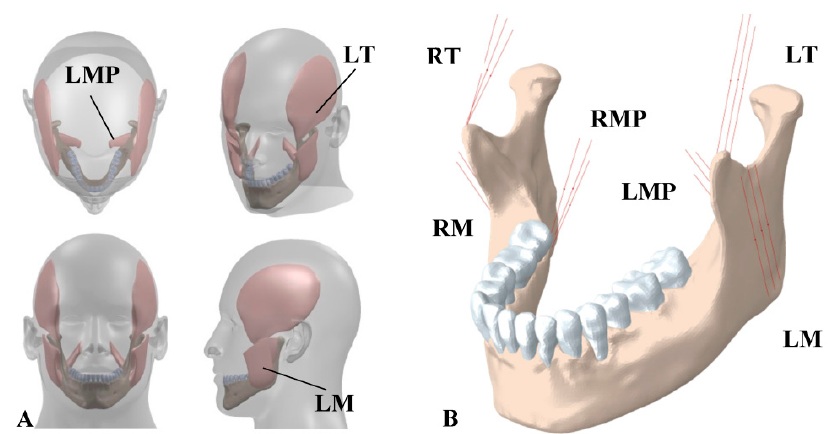
Figure 6. ( A ) 3D structures of major masticatory muscles; ( B ) Each muscle is simulated by three truss elements, considering the origin and insertion points taken from the 3D structures of muscles. RT = Right temporalis, LT = Left temporalis, RMP = Right medial pterygoid, LMP = Left medial pterygoid, RM = Right masseter, and LM = Left masseter.